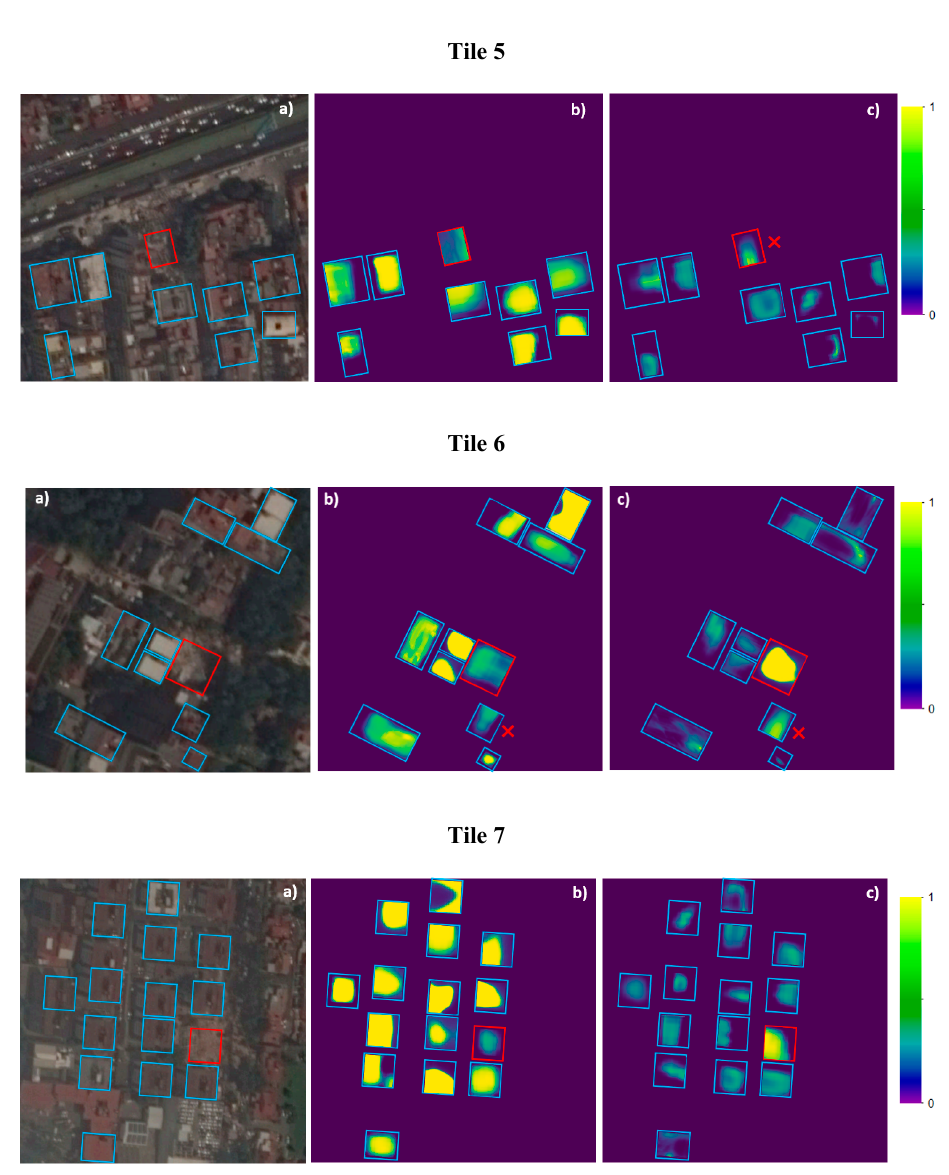
Figure A1. Network prediction after the 2017 M 7.1 Pueblo earthquake in Mexico on seven different tiles: ( a ) satellite imagery tiles labeled with demolished (red) and intact (blue) buildings; ( b ) network’s predictions of intact building instances; ( c ) network’s prediction of demolished building instances. Satellite images from Google Earth; all rights reserved. Red x indicates footprints mis-classified or missed by the network.